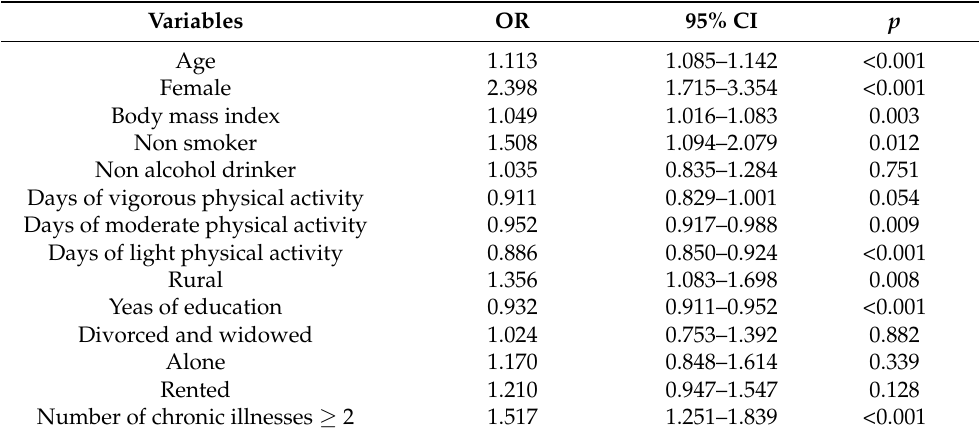
Table 3. Logistic regression predicting the likelihood of high symptom